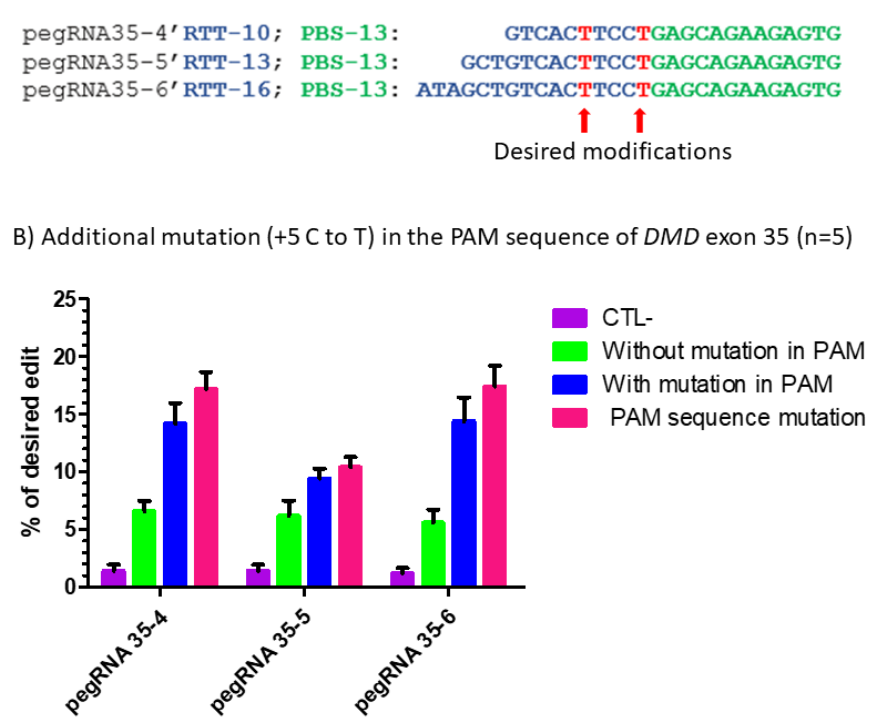
Figure 6. Prime editing of DMD exon 35 with an additional mutation in the PAM sequence. ( A ) The sequences of the Primer Binding Site (PBS, in green) and the Reverse Transcriptase Template (RTT, in blue) of the three pegRNAs targeting DMD exon 35. The T in red in the RTT represents the desired nucleotide to be inserted in the strand not containing the PAM sequence (i.e., in the sense strand in this case) to transform the arginine codon (CGA) into a stop codon (TGA). ( B ) Results of Sanger sequencing and EditR analysis of prime editing of the DMD exon 35 with a modification in the PAM. There was a 1% background level of thymidine (T) in the position of the targeted nucleotide. The pegRNA35-4 (cid:48) showed a significant reduction (only 1%) in the editing percentage of the arginine codon (CGA) into a stop codon (TGA). The pegRNA PAM (5 (cid:48) AGG3 (cid:48) ) was modified to a 5 (cid:48) AAG3 (cid:48) in 2% of the sequence. The pegRNA35-5 (cid:48) and pegRNA35-6 (cid:48) induced, respectively, 9 and 14% C to T to create the desired stop codon (TGA) in exon 35 of the DMD gene. The pegRNA35-5 (cid:48) and pegRNA35-6 (cid:48) also induced, respectively, 10 and 15% G to T modification, changing the AGG PAM sequence into an AAG sequence, which is not a PAM. These experiments were carried out in five independent replicates ( n =